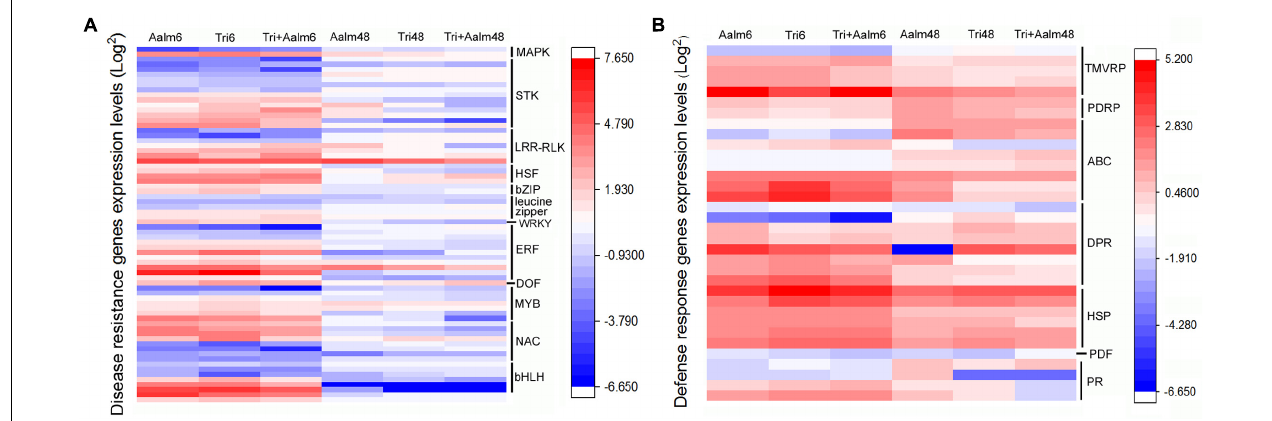
FIGURE 3 | Different expression of resistant genes and defense response genes. (A) Differential expression of resistant genes. MAPK : mitogen-activated protein kinase gene, STK : serine/threonine-protein kinase gene, LRR-RLK : leucine-rich repeat receptor-like kinase gene, HSF : heat shock transcription factor gene, bZIP : bZIP transcription factor gene, WRKY : WRKY transcription factor gene, ERF : ethylene-responsive transcription factor gene, DOF : DNA binding with one finger gene, MYB : MYB transcription factor gene, NAC : NAC transcription factor gene, bHLH : bHLH transcription factor gene. (B) Differential expression of defense response genes. PDRP : pleiotropic drug resistance protein gene, TMVRP : tobacco mosaic virus (TMV) resistant protein gene, ABC : ABC transport protein gene, DRP : disease resistance protein gene, HSP : heat shock protein gene, PDF : defensin gene, PR : pathogenesis-related protein